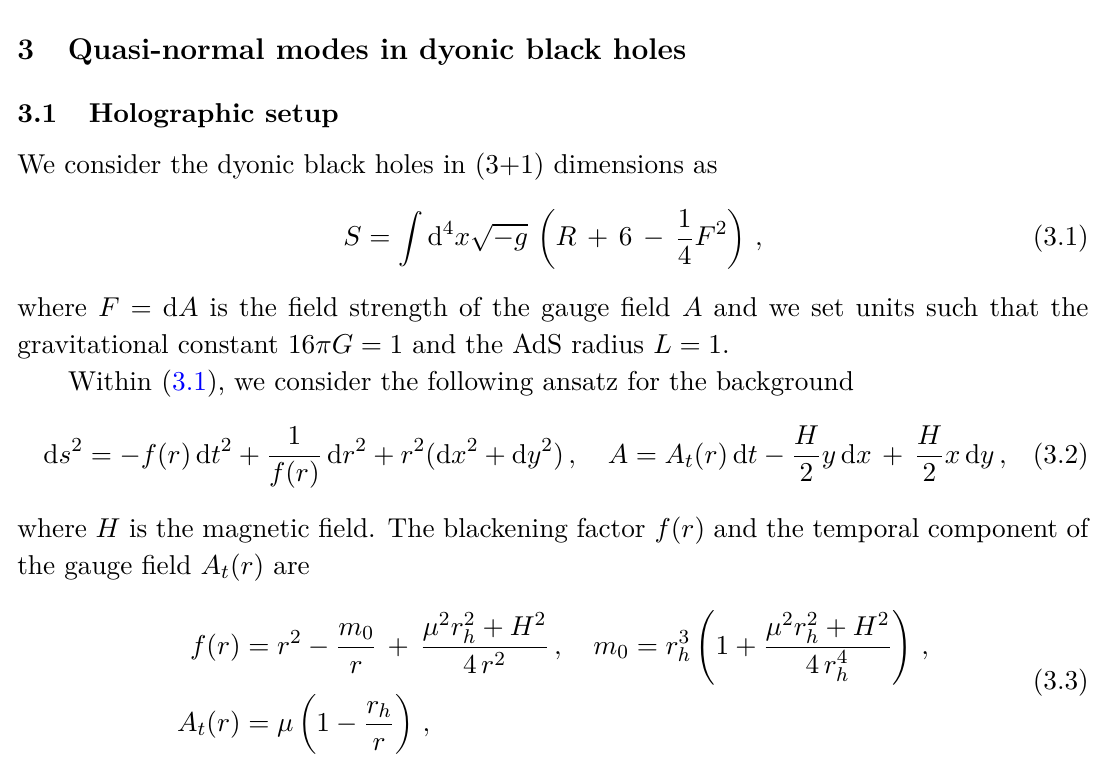
Table 2. Summary of the dispersion relations from hydrodynamics at finite density. part Hρ due to the finite density, called the cyclotron frequency, which is consistent with (cid:15) + P the zero wave vector analysis [5,